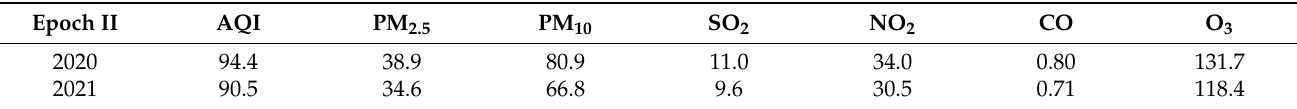
Table 6. Average values of air quality during the post-COVID epoch in 2020 (and the same epoch